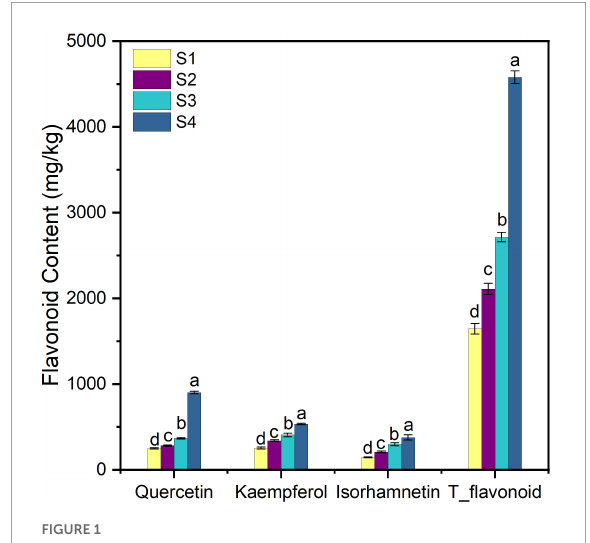
FIGURE1 The concentration of three flavonols and total flavonoids in Ginkgo leaves at different altitudes. The significant difference among the groups is represented by different letters ( p <